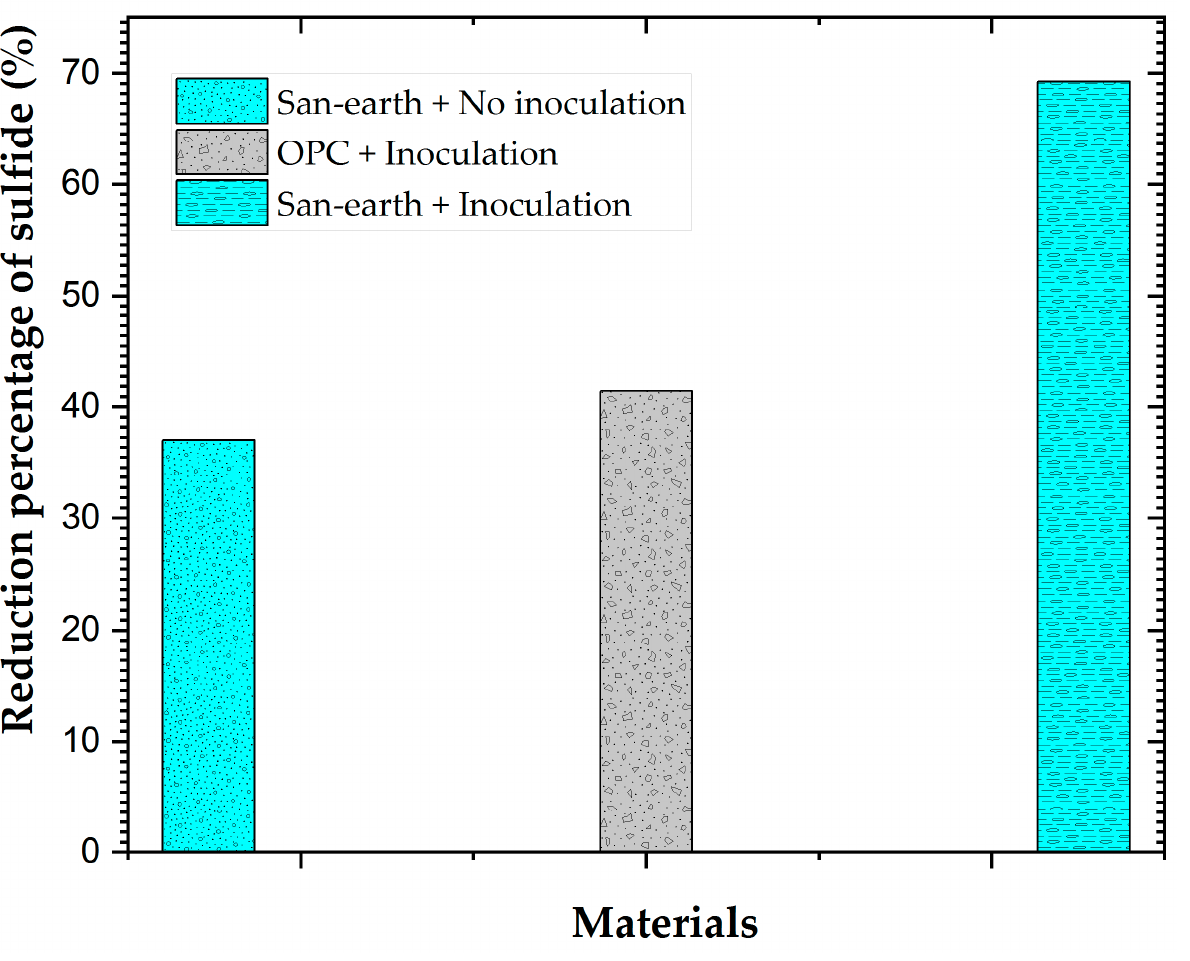
Figure 7. Percentage of the sulfide reduction in the experiments with/without the inoculation with EPB.